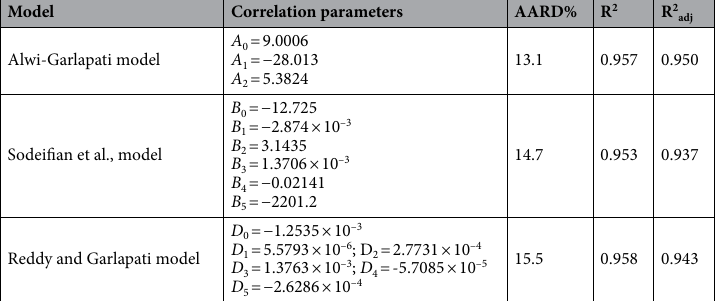
Table 4. Correlation constants of the recent models.